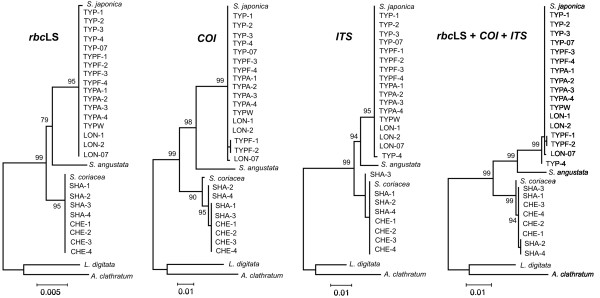
Phylogenetic trees of the rbc LS, COI, ITS , and concatenate sequences (4,286 bp total) ofSaccharina japonicamorphological forms. The topology of trees obtained with Maximum likelihood and Neighbor-joining methods were congruent. Numbers at the nodes are bootstrap percent support values based on 1,000 replications in Maximum likelihood analysis. Saccharina latissima was excluded from this analysis due to recombination in the COI gene (see text). Other comments as in Figure 1.